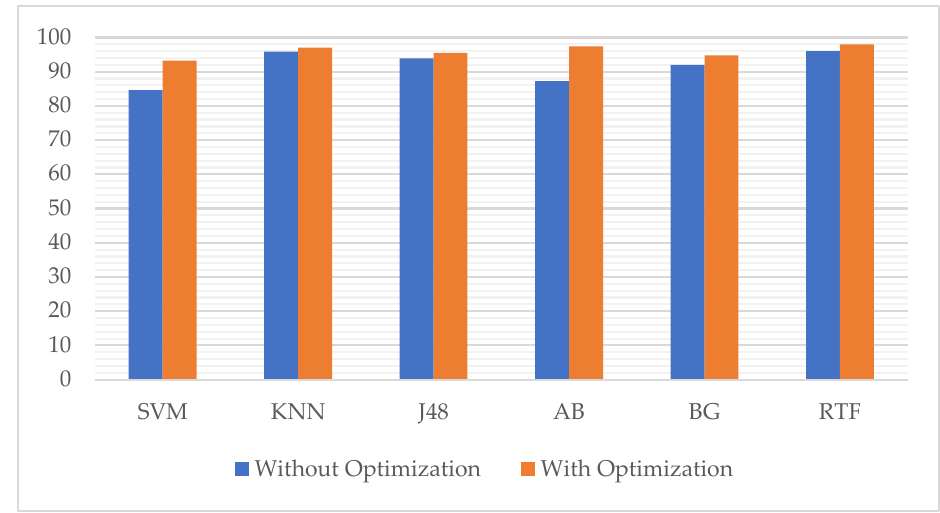
Figure 8. Accuracy comparison of machine learning models without and with optimization.